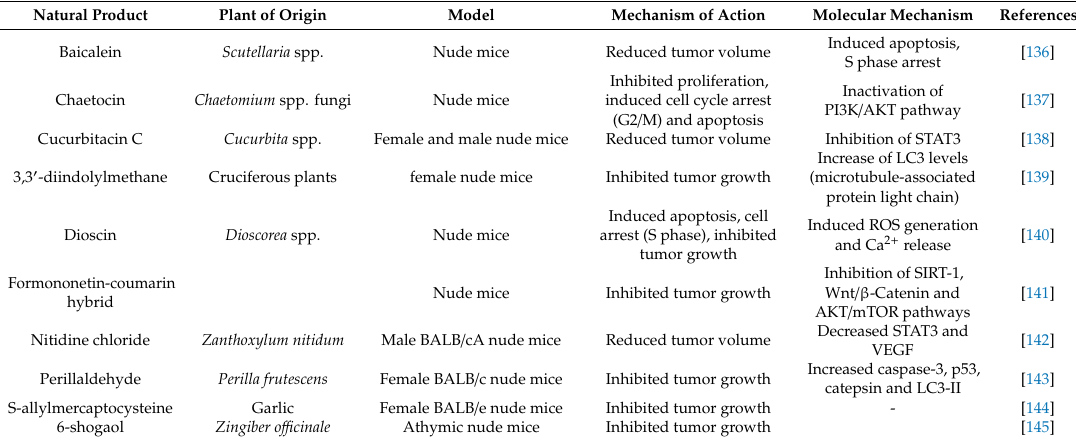
Table 3. The examples of in vivo studies on the activity of natural products against gastric cancer in xenograft